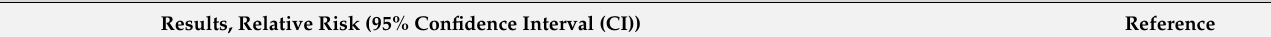
Meat, Fish, Dairy Products, and Preservation/Processing of Foods